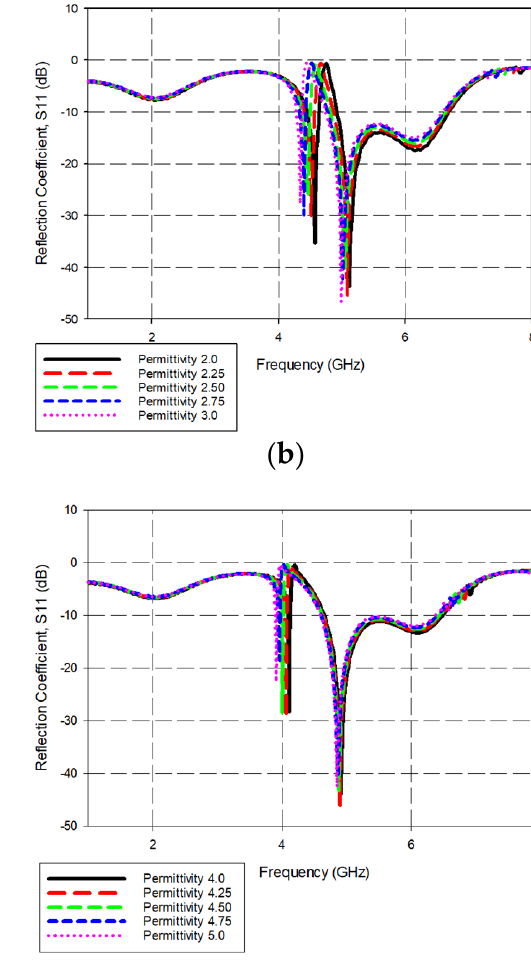
Figure 16. The graph of small range of permi tt ivity simulation ( a ) 1–2 ( b ) 2–3 ( c ) 3–4 ( d ) 4–5. As can be seen in Figure 16, when the dielectric constant changes from 1 to 5 with a scale of 0.25, the frequency shifts to a lower frequency range with reference to the peak value of S11. The relation between the dielectric constant and the frequency shift is plo tt ed, as shown in Figure 17.